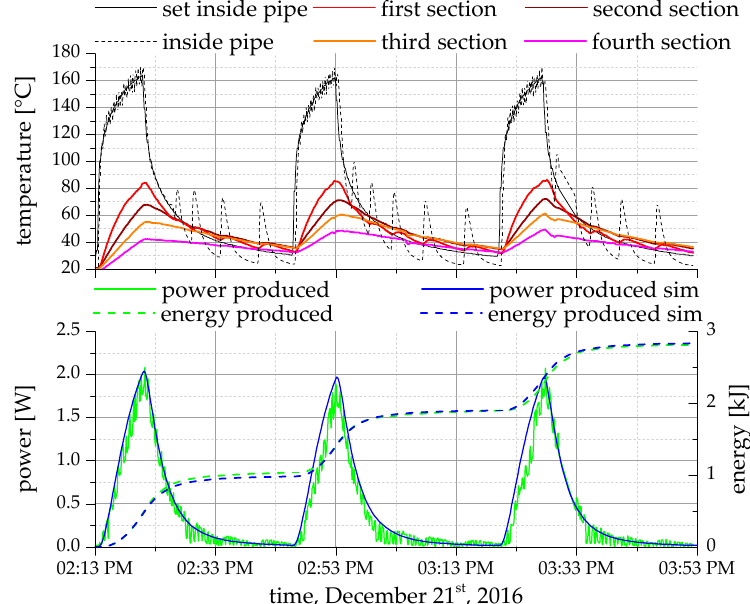
Figure 9. Measurement and simulation data for the heating mockup: heating scenario of the oil-fired heating on campus on 15 November 2016 between 8:42 a.m. and 10:22 a.m., executed on 21 December 2016 at the Heating Mockup. Above: temperature curves of each section as well as the set and real inside pipe temperature at the beginning; below: produced power and energy of the EHS and the corresponding simulation results.